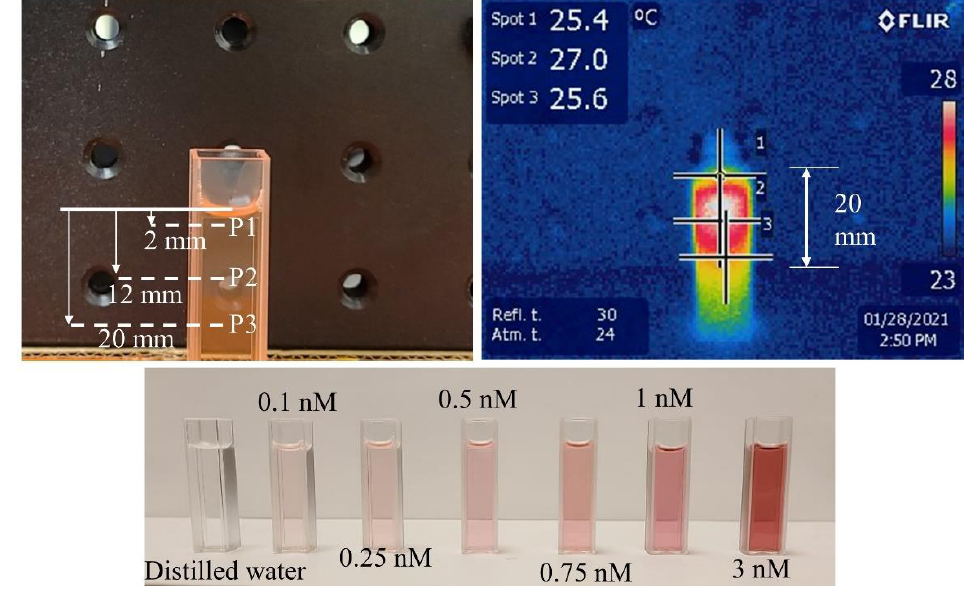
Figure 1. Gold nanorods (GNRs) photothermal heating with 808 nm